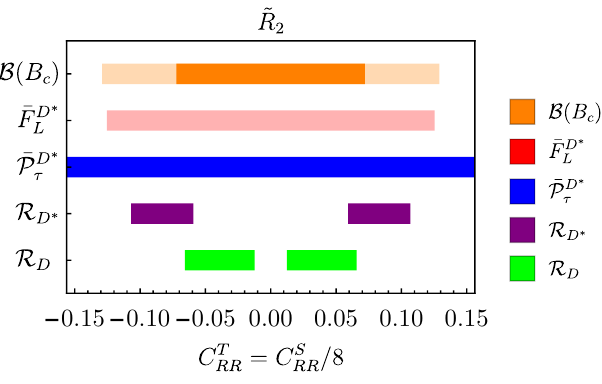
at 1 (cid:27) . The light orange and red shaded L